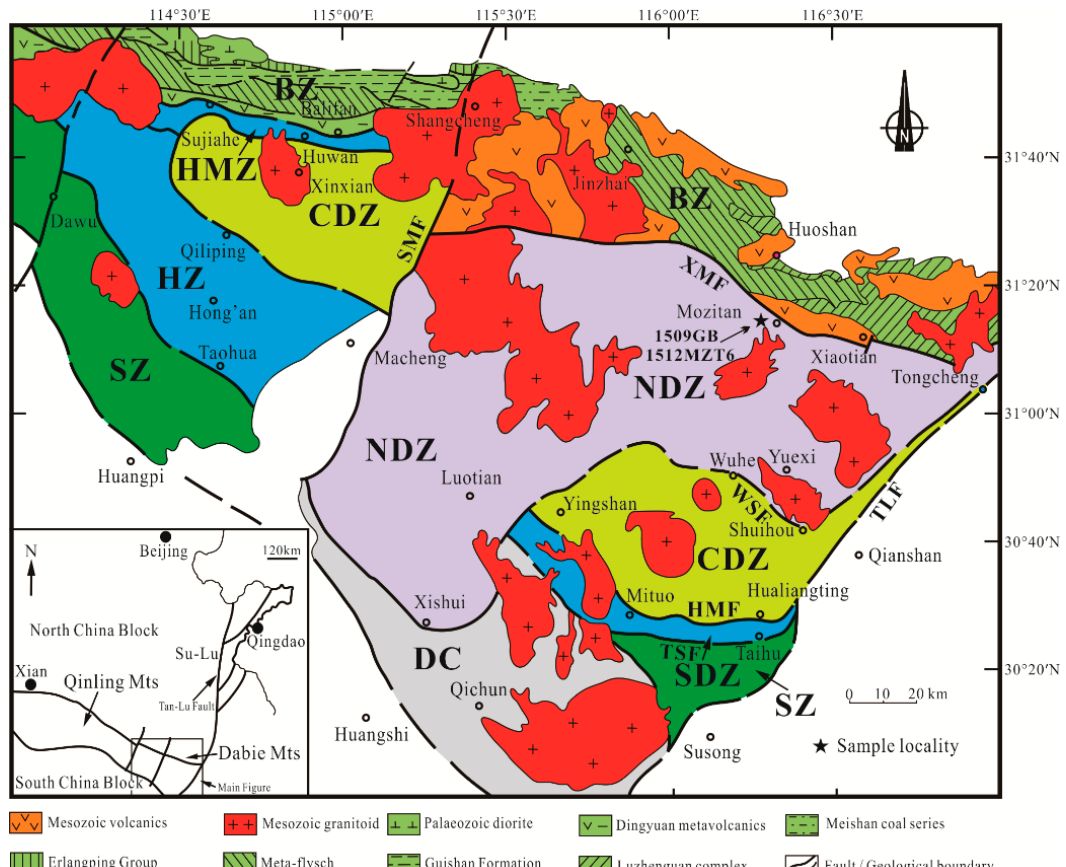
relatively low-grade composite units, whereas the other zones belong to the deeply subducted South China Block [52–54].